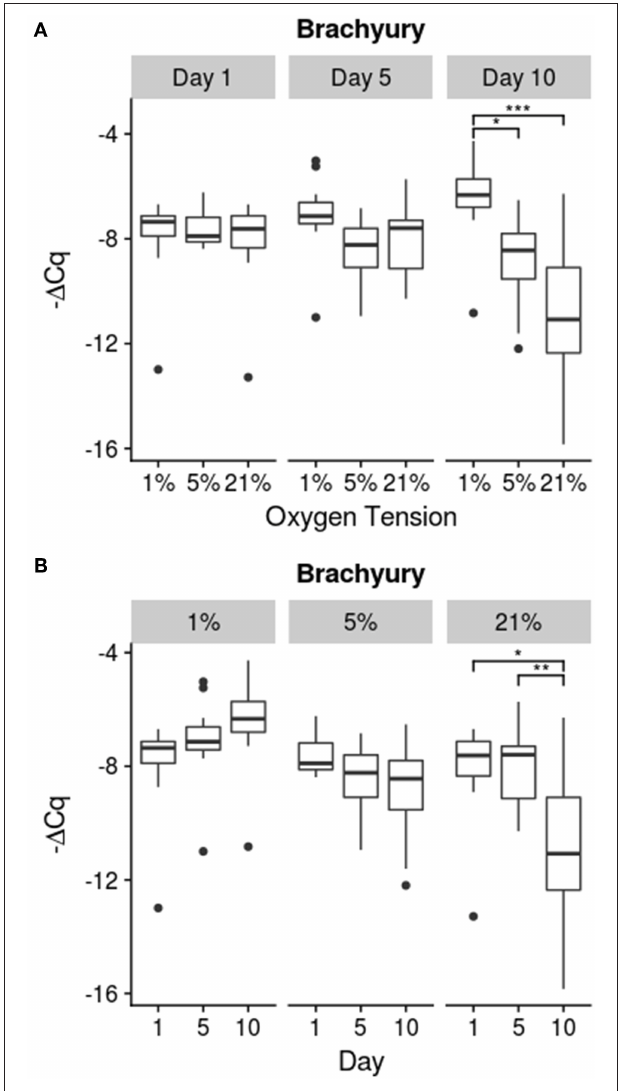
FIGURE 3 | Brachyury (T) Expression. Relative expression is determined using the - 1 Cq method. (A) compares oxygen tension within days while (B) shows changes over time within each oxygen tension; significance shown as * p ≤ 0.05, ** p ≤ 0.01, and *** p ≤